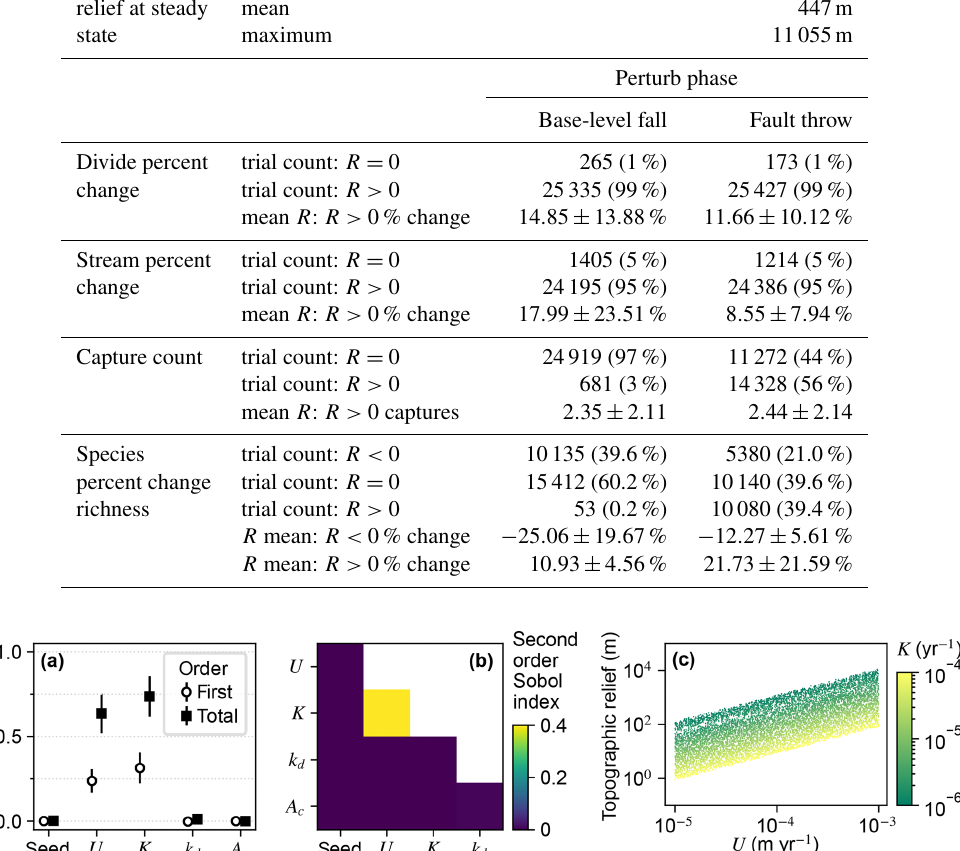
Figure 5. Sobol indices of topographic relief. (a) The first- and total-order Sobol indices of relief at the initial steady state. Model input factors are on the x axis; “seed” is the initial elevation seed. (b) Second-order Sobol indices of relief. Factors are on the x and y axes. (c) Relief versus U and K . Each point represents one of the unique steady-state landscapes created in the initial conditions